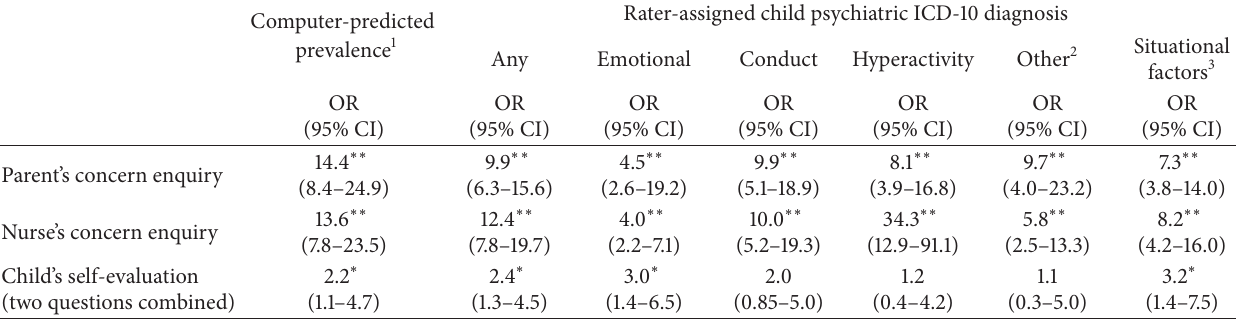
Table 3: The odds ratios (OR) for child outcomes related to parent’s and nurse’s evaluation of the child’s difficulties and child’s self-evaluation of emotional well-being according to DAWBA assessment in a sample of Finnish 4–9-year-old children ( 𝑛 = 646). The OR of each separate evaluation (no or mild difficulties/concerns versus more severe options) for each outcome measure is shown.